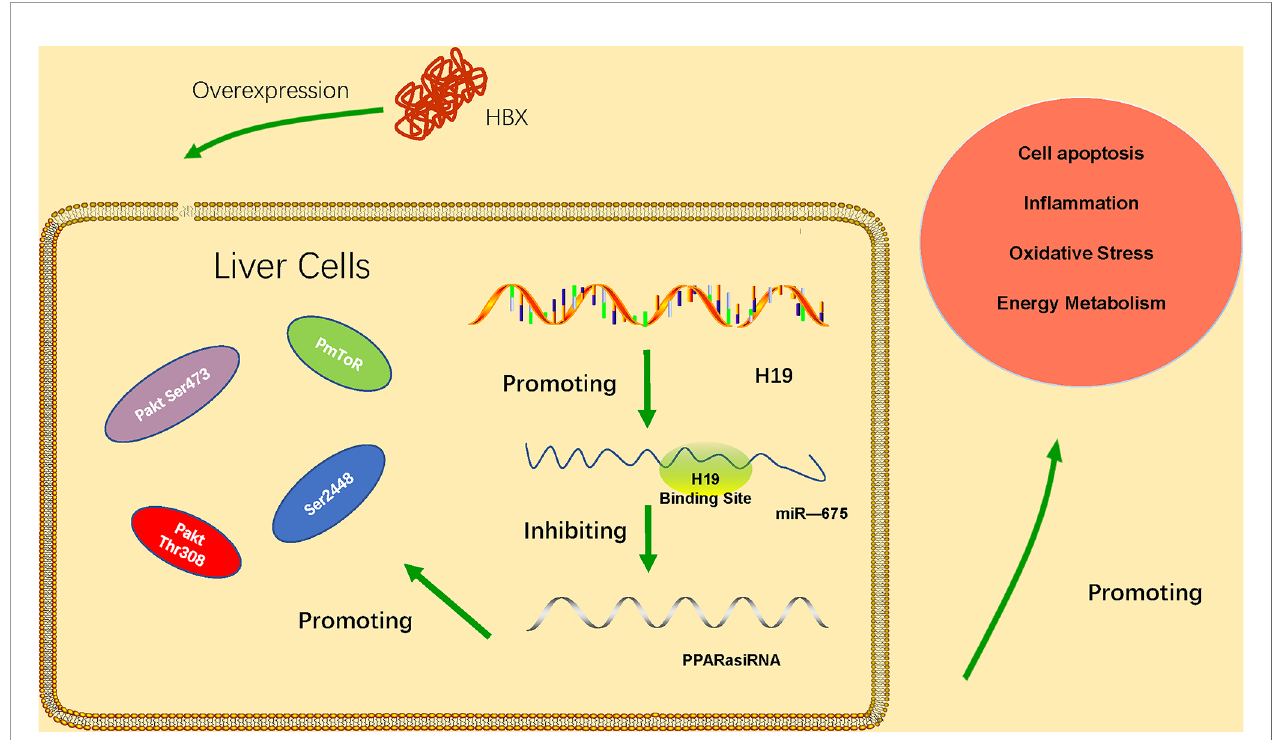
FIGURE 1 | LncRNAs listed in this paper has been divided into three parts by their biological functions. The fi rst part mainly introduce the lncRNAs which can advance or inhibit the proliferation of HCC cells; and second part shown the lncRNAs play a crucial role in HCC migration and invasion; and the last part present the lncRNAs abnormal expressing in the serum of HCC